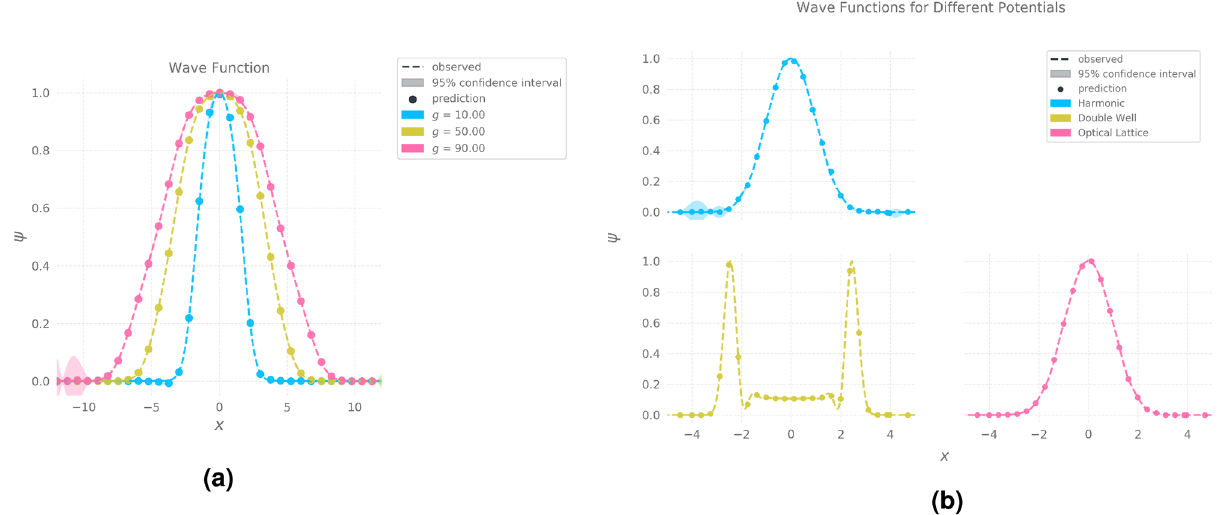
Figure 2. (a) Simulated and predicted ground state wave functions for different values of the interaction parameter g = 10, 50, 90 (b) Prediction of wave functions conditioned on different trapping potentials - Harmonic, Optical Lattice, Double Well